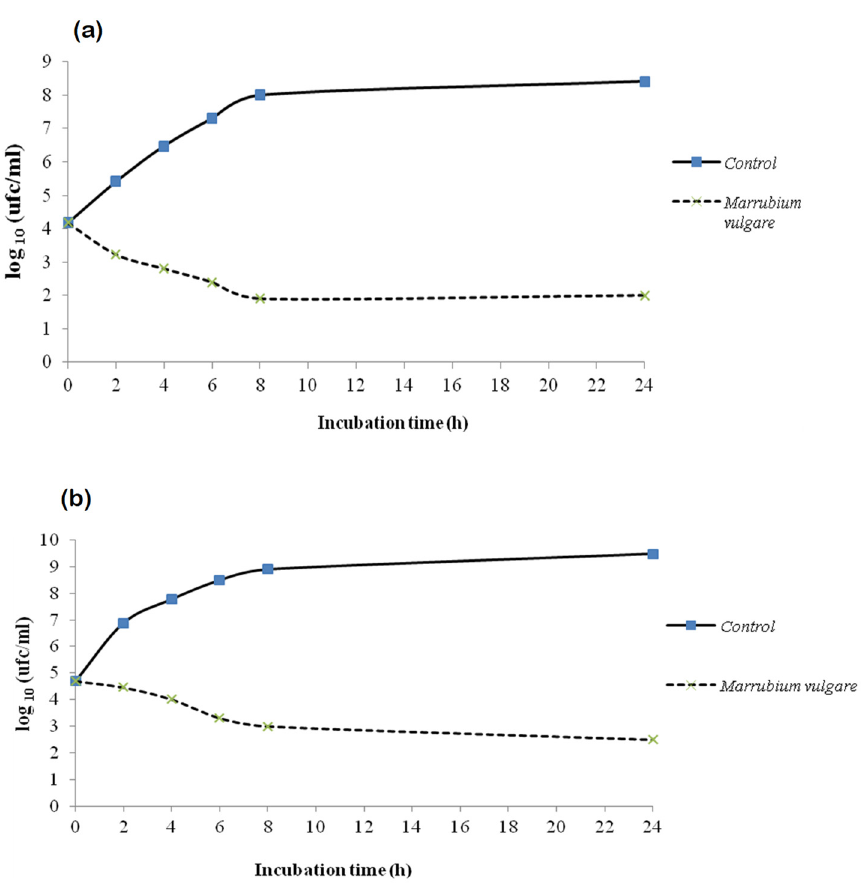
Figure 2. Time–kill curves E. coli ( a ) and L. monocytogenes ( b ) cultures untreated and treated with the methanolic extract of M. vulgare at concentration corresponding to MIC.